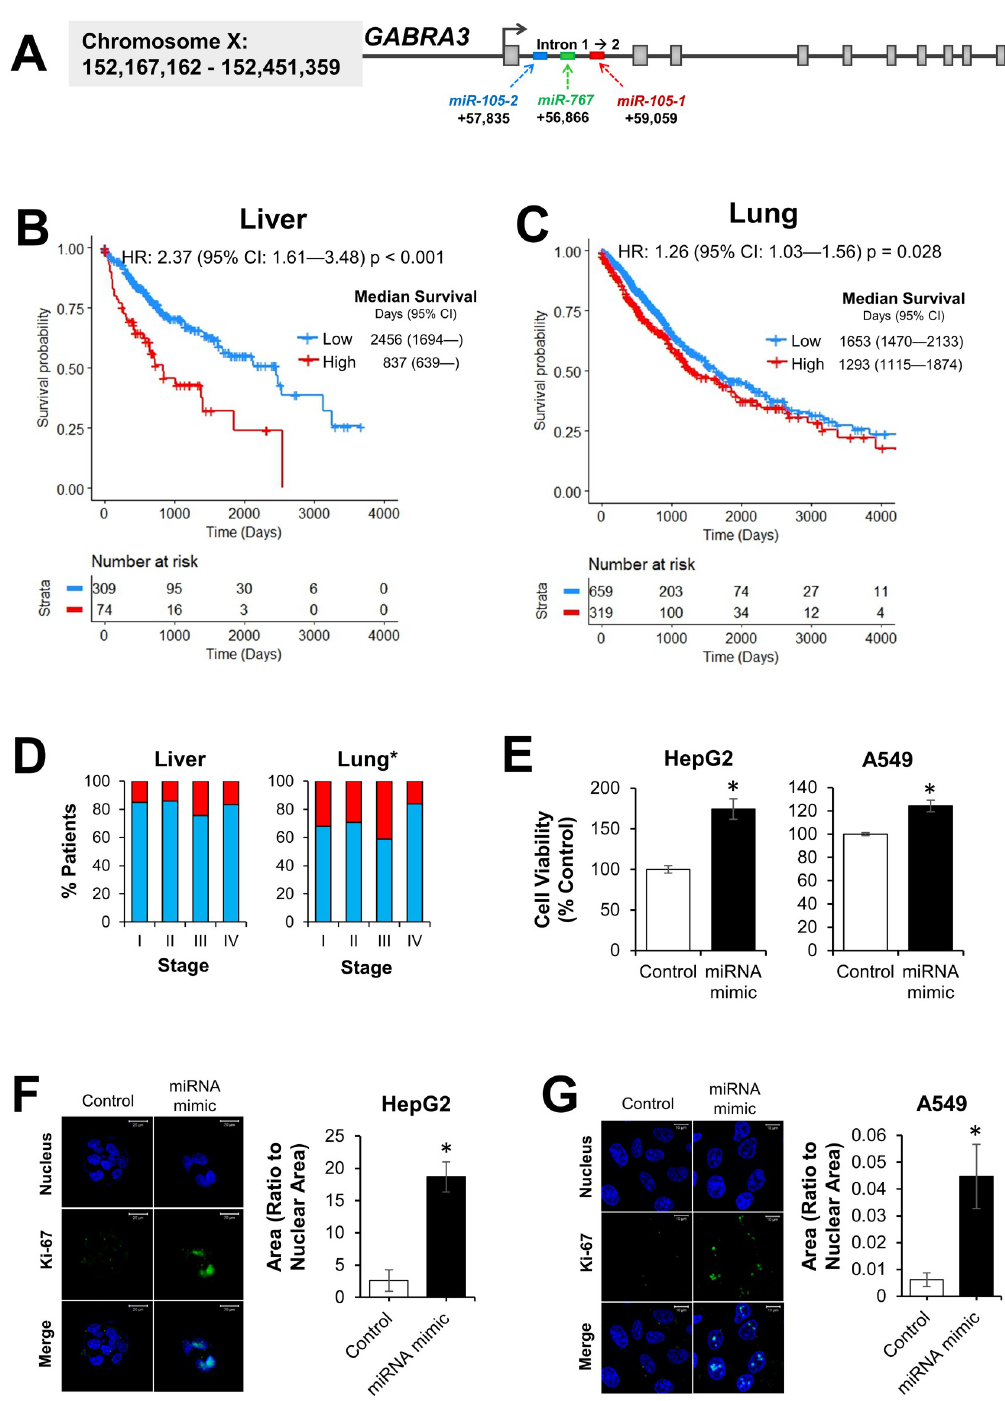
Fig 5. miR-105 and miR-767 are associated with overall survival and cellular proliferation in liver and lung cancer. (A) genomic location of miR-105-1, miR-105-2, and miR-767. (B) Liver and (C) lung cancer patients were divided into low and high miRNA expressers. For each cancer type, a Cox proportional hazards regression was fit. The reported hazard ratio (HR) and 95% confidence interval (CI) denote the risk of death in the high expression group compared to the low expression group. Median survival time is given in days with a 95% CI. (D) The relationship between miRNA expression and TNM stage. Graphs show the proportion of individuals with high (red) and low (blue) miR-105 and miR-767 expression within each stage. Differences in TNM staging between high and low expressers was tested using Chi square tests. � p < 0.05. (E) HepG2 and A549 cells were treated with miR-105 and miR-767 mimics or a negative control. Cell proliferation marker Ki-67 in (F) HepG2 and (G) A549 cells. Representative images show nuclear staining with Hoechst (blue) and Ki-67 staining (green). N = 3, � p < 0.05.